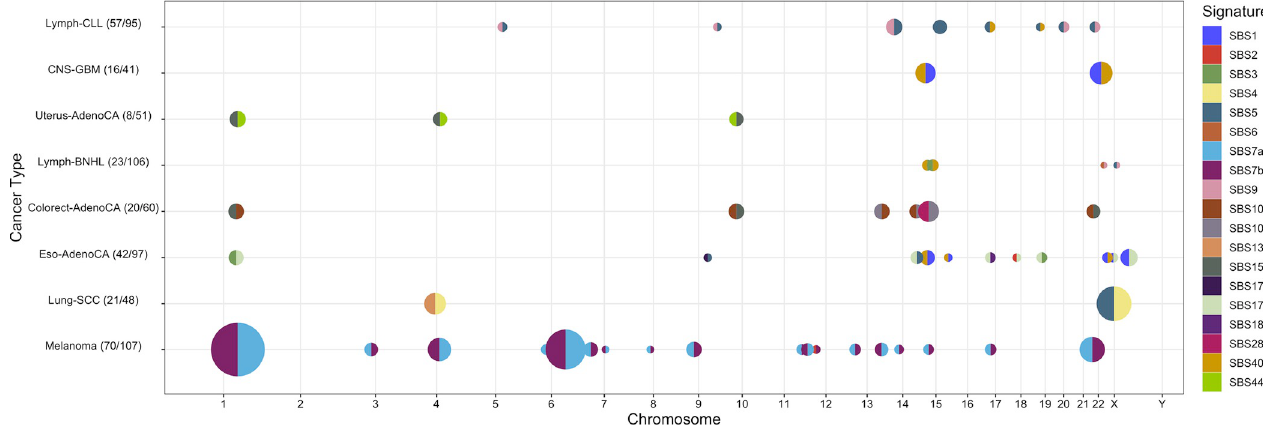
Fig 2. Recurrent changepoint regions across eight tumor types. 54 genomic regions include a changepoint found in seven or more samples for a given tumor type. Each of these recurrent changepoint regions are indicated by a point, where COSMIC V3 signatures [1,3] are indicated by color. Changepoints are summarized by the signature whose activity decreases the most on average (left half) and the signature whose activity increases the most on average (right half). Proportion of samples exhibiting a changepoint is encoded by size, and the number of samples affected is indicated in the tumor type label (n/N). Changepoints that appear in fewer than seven samples are